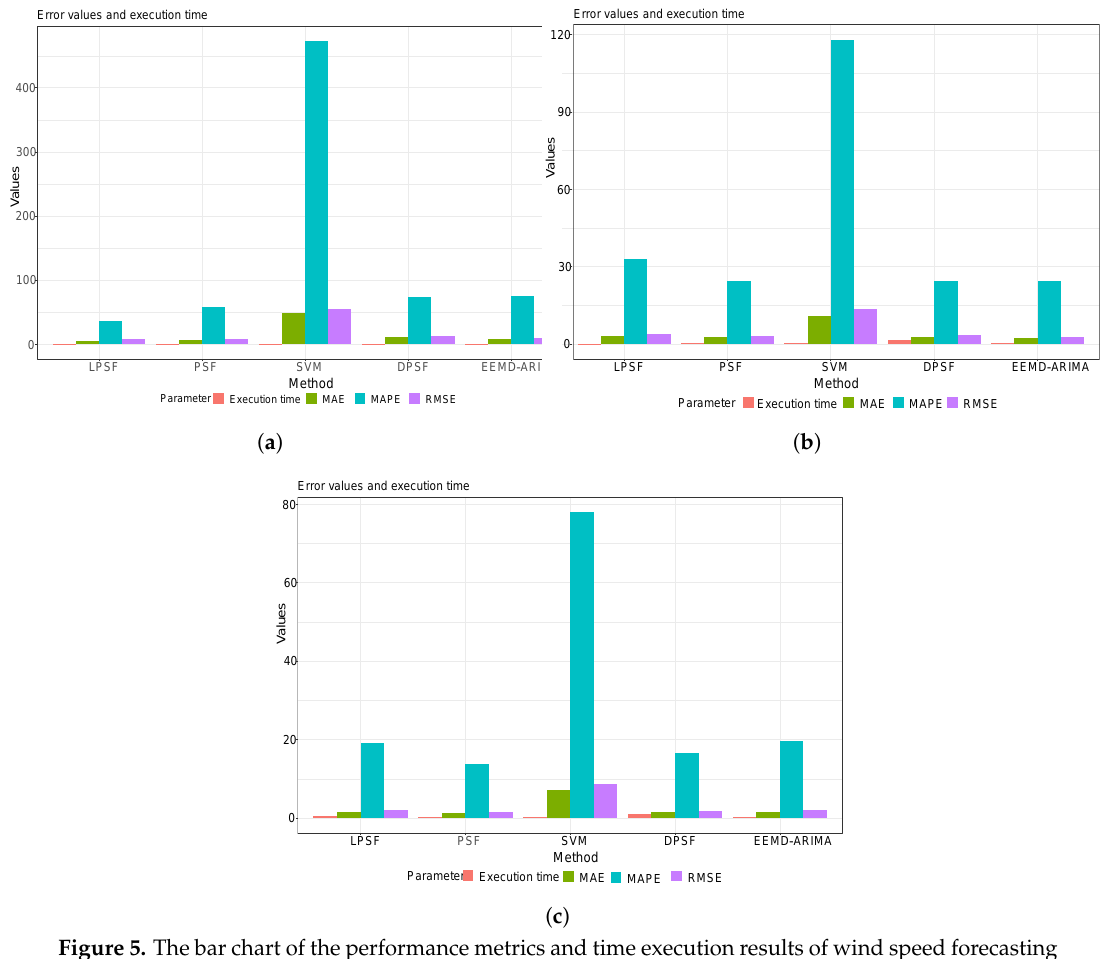
Figure 5. The bar chart of the performance metrics and time execution results of wind speed forecasting for the daily ( a ), weekly ( b ) and monthly ( c ) at Robinson station.